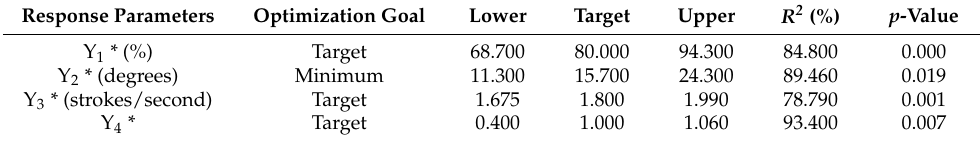
Table 3. Set response parameter limits for predicting the optimized suspension formulation. Response